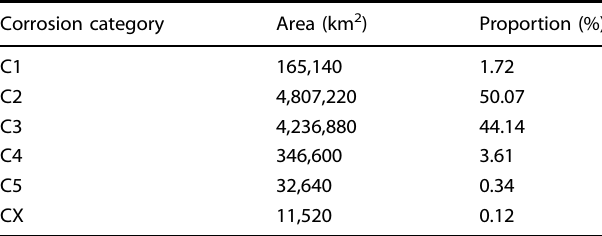
Table 5. The area and proportion of different corrosion categories.